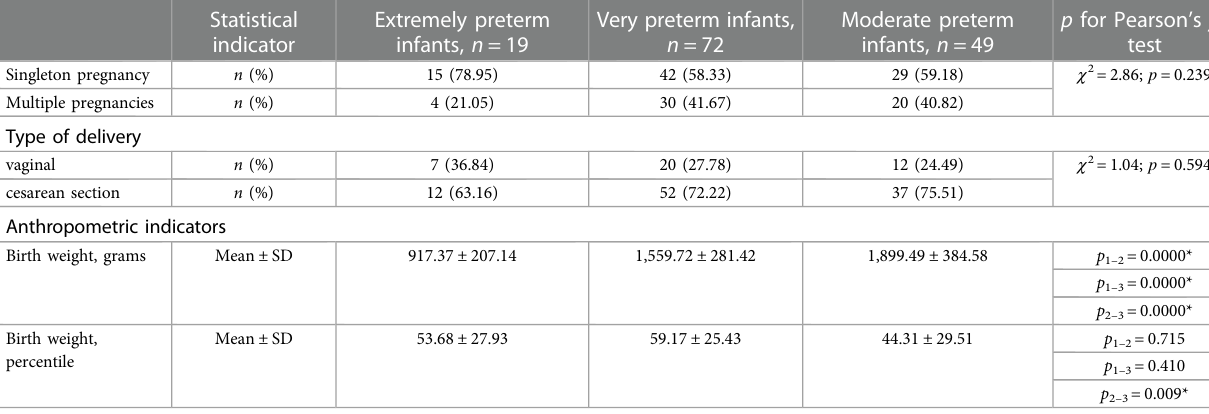
TABLE 1 History of pregnancy and delivery, anthropometric indicators of the study population.